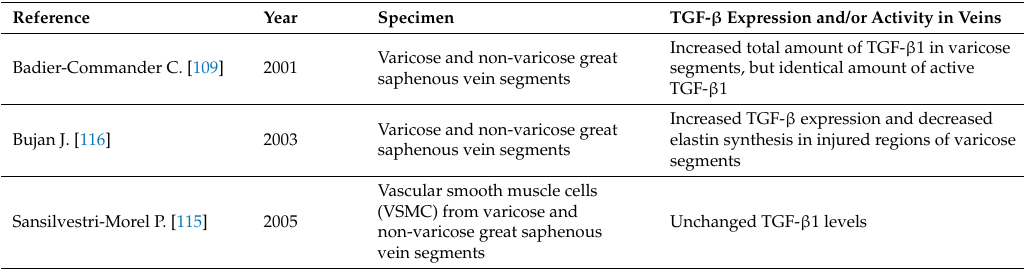
Table 1. Studies regarding TGF- β 1 expression and/or activity in